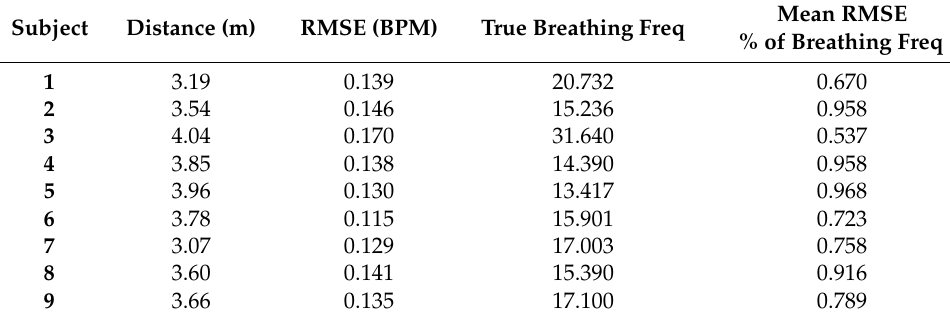
Table 7. Root mean squared error results on test subjects for ranges 3–4